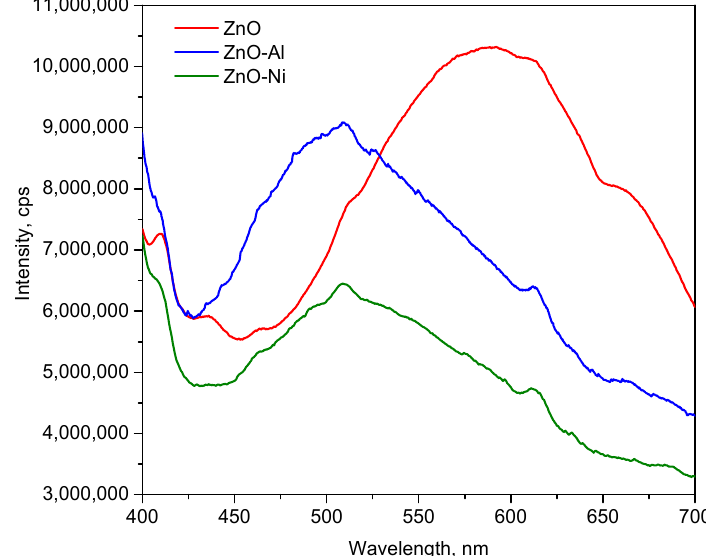
Figure 3. Optical transmission spectra of ZnO and doped ZnO nanoparticles.